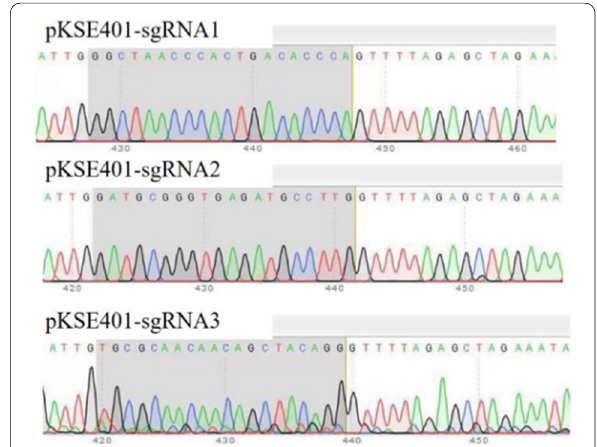
Fig. 3 Sequencing identification of three sgRNA sequences (Gray parts represent the sgRNA base sequences)